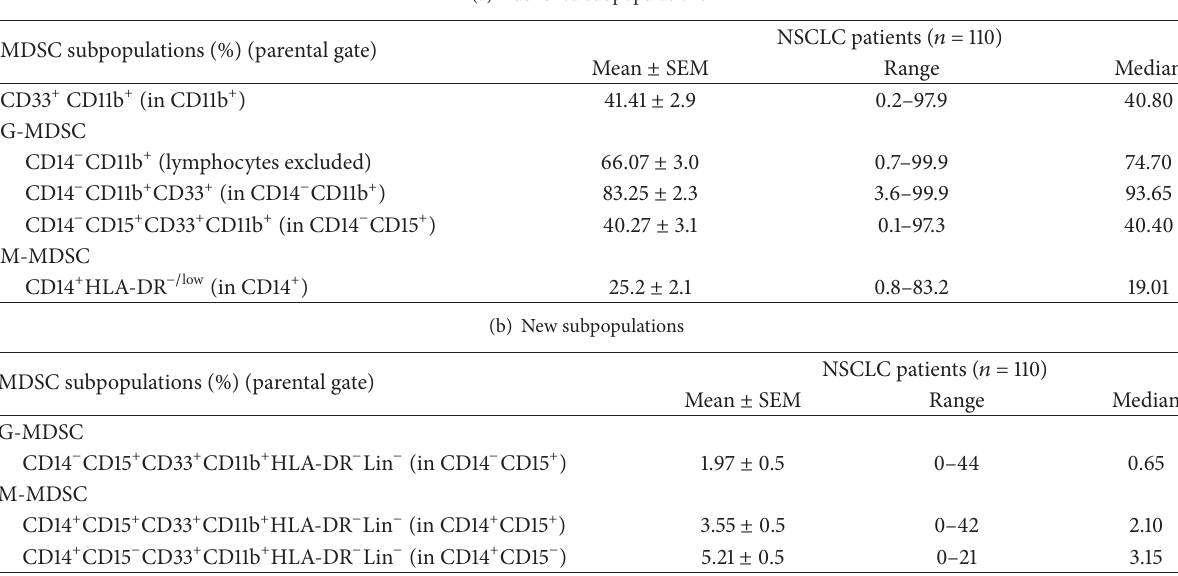
Table 2: Percentages of MDSCs subpopulations in NSCLC patients. (a) Published